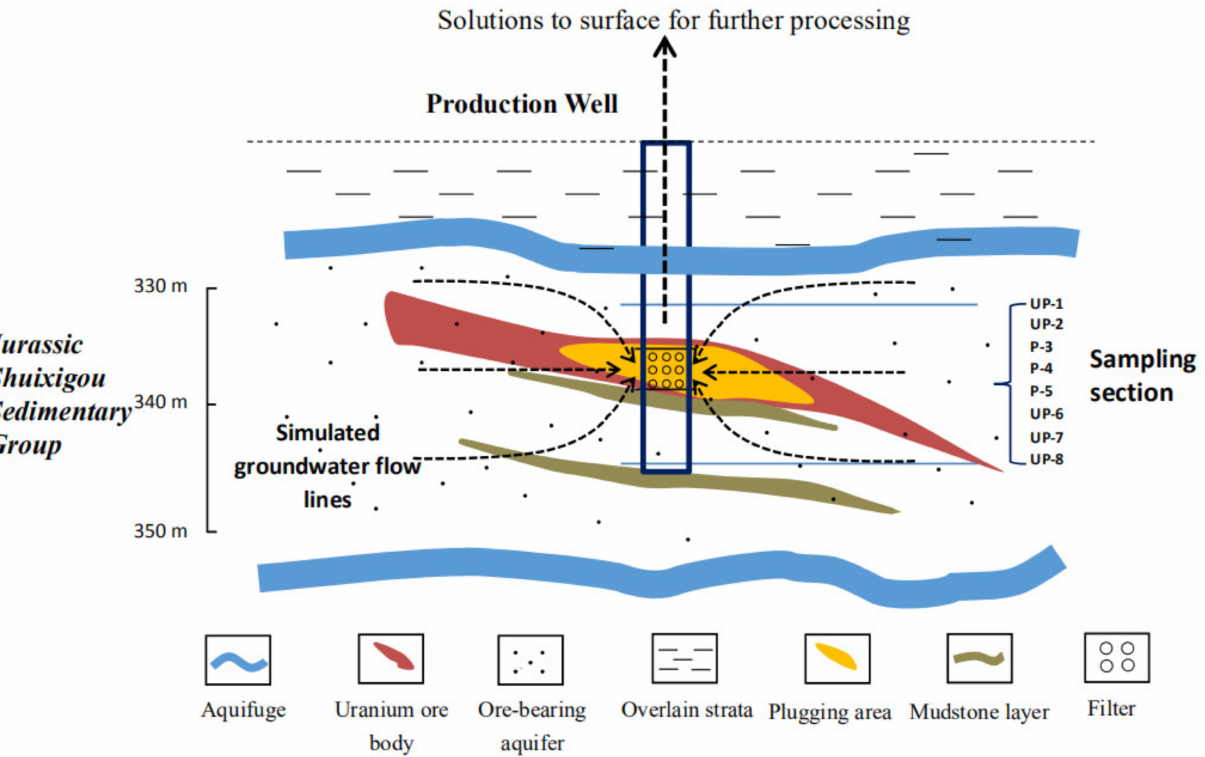
Figure 1. The cross-section of studied uranium ore horizon showing the sampling